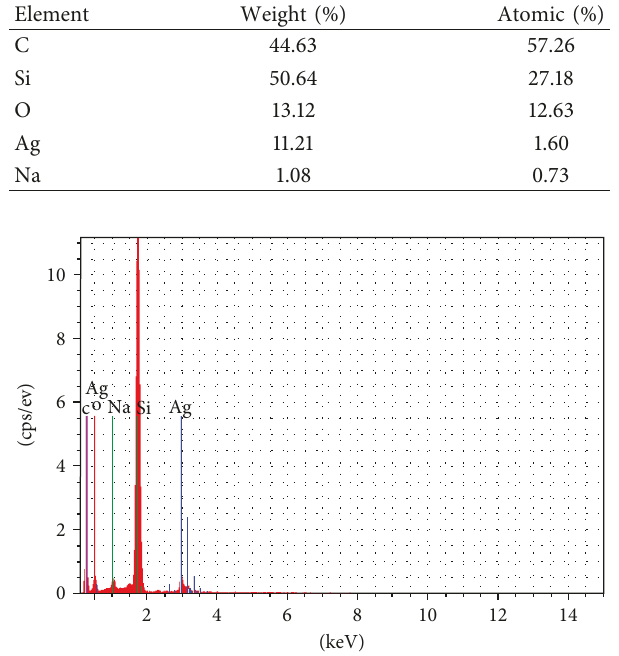
Figure 4: Silver nanoparticle EDX